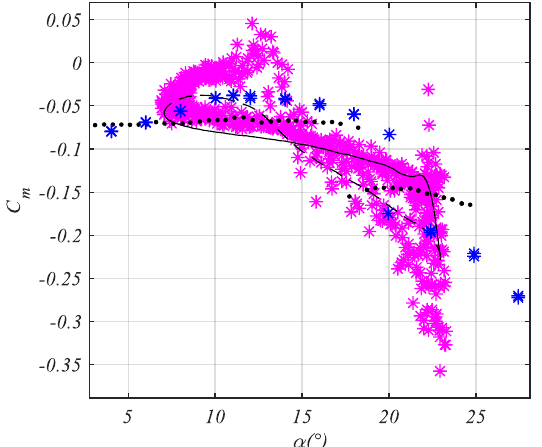
Figure 24. Steady and unsteady moment coefficient (mean angle 15°/amplitude 8°). Comparison with literature data [24]. Symbols as in Figure 23.